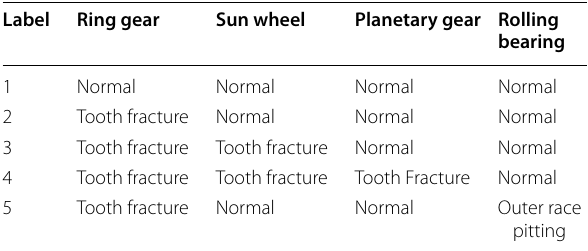
Table 4 Description of the experimental failures of the planetary gearing system